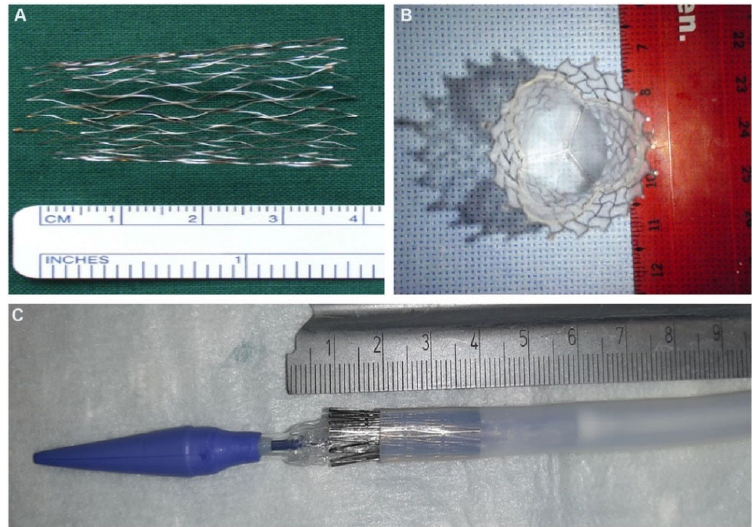
Figure 3. ( A ) Self ‐ expanding nitinol stent, sizes 24 mm (ventricular)/22 mm (middle)/20 mm (pulmonary) with an overall length of 35 mm. ( B ) Top view of tricuspid polycarbonate urethane valved stent. ( C ) The valved stent is crimped in a 14 ‐ Fr delivery catheter with a smooth